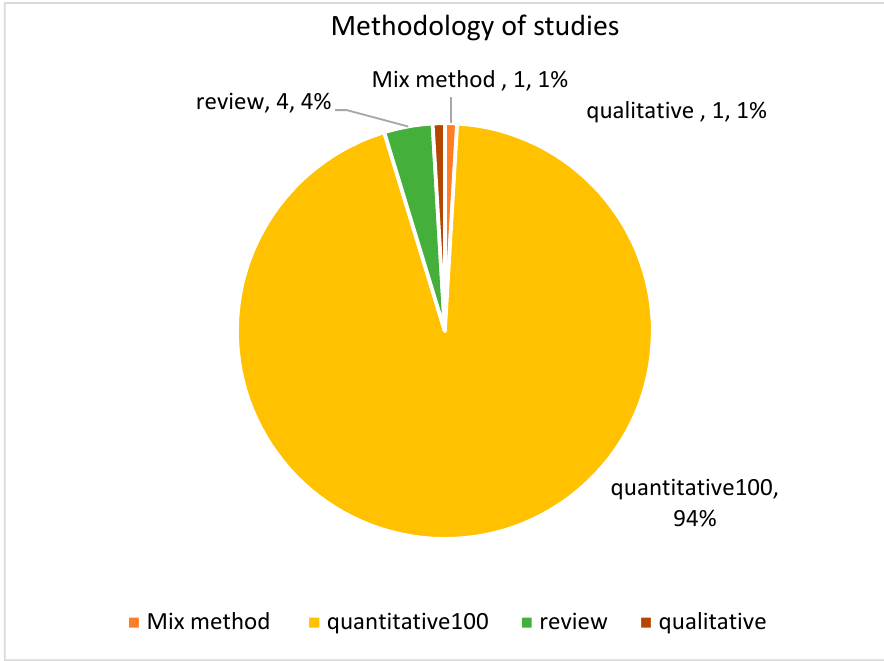
Figure 4. Research methodology.